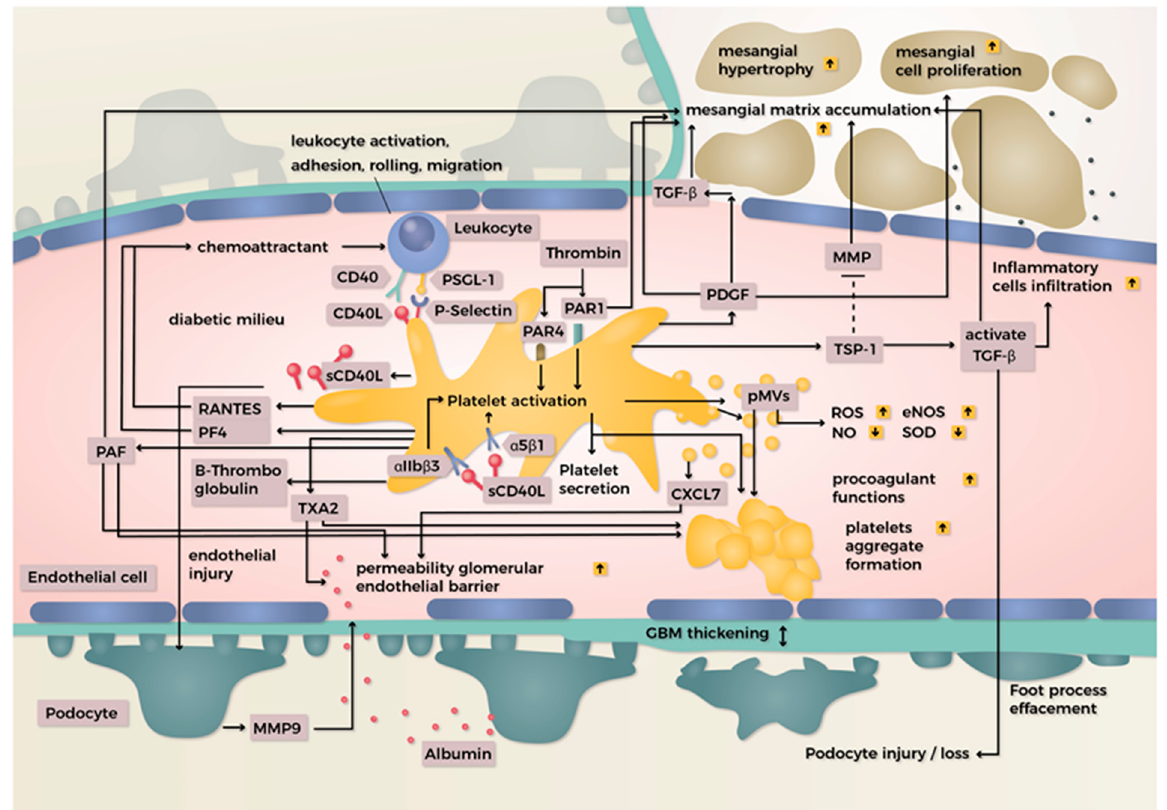
Figure 1. Mechanisms of platelet involvement in the pathogenesis of diabetic kidney disease. Under diabetic conditions, platelet hyperreactivity is characterized by increased activation and signaling of platelet receptors, leading to platelet adhesion, activating other platelets to form aggregates, and contributing to the coagulation cascade. Activated platelets directly bind to leukocytes through a P-selectin–PSGL-1, CD40-CD40L interaction and stimulate leukocytes extravasation. Soluble CD40L produced by activated platelet binds to α IIb β 3 and α 5 β 1 integrin and mediates platelet activation. sCD40L may affect podocytes, leading to an increase in the expression of MMP9 and enhancing glomerular permeability. PAR receptors are also expressed in platelets, which can be activated by thrombin signaling, thus mediating platelet activation. Platelet activation releases cytokines and chemokines such as RANTES/CCL5, PF4/CXCL4, and β -TG/CXCL7. Platelets contain numerous growth factors such as PDGF, which contribute to mesangial cell proliferation and matrix accumulation in DKD. With TSP-1, PDGF also stimulates and activates the release of TGF- β , responsible for mesangial matrix accumulation, renal infiltration with inflammatory cells, and podocyte damage. TXA2 and PAF secrete from platelets, increase platelet aggregation, and enhance glomerular permeability, inducing proteinuria. PAF also play a part in subsequent inflammatory reaction and stimulate ECM deposition. Platelets also release abundant MVs and induce the production of ROS, decrease NO, and inhibit the activities of eNOS and SOD. Platelet MVs also contribute to the injury of glomerular endothelial cells by releasing